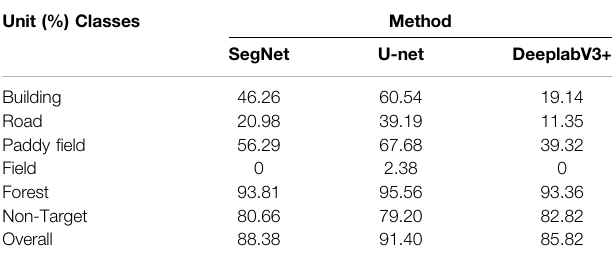
TABLE 7 | Satellite image dataset algorithm pixel accuracy of each classes. Unit (%)